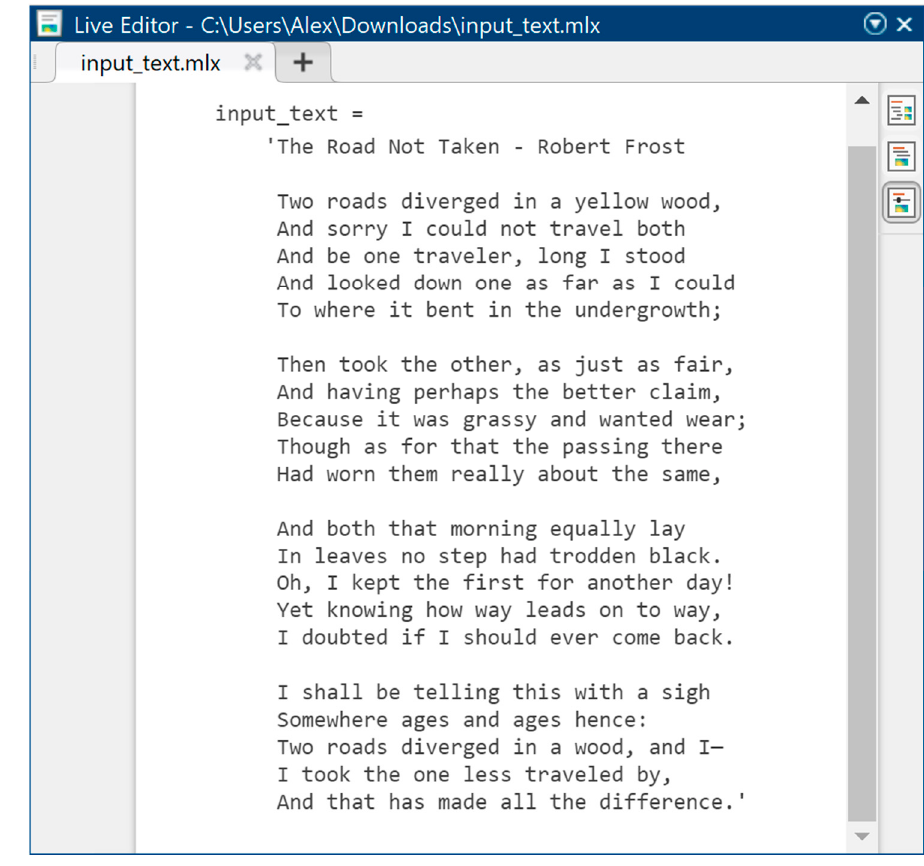
Figure 6. Original text information in the form of characters.